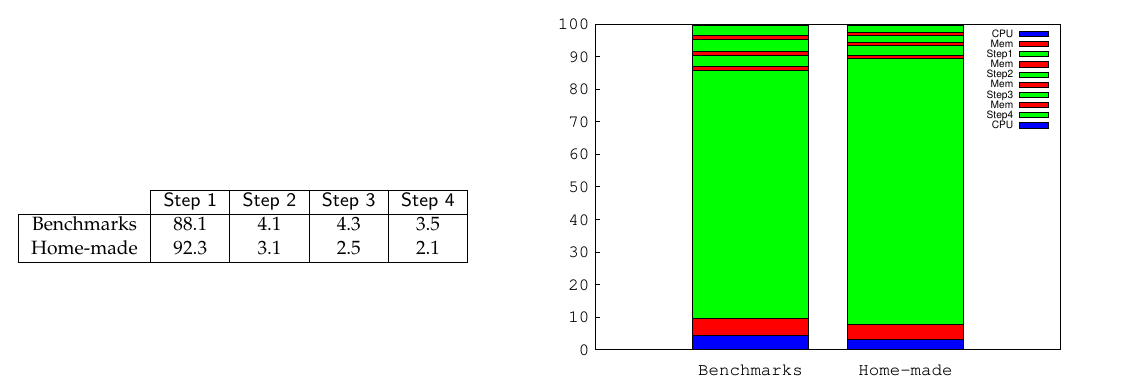
Figure 7. A deeper analysis of our application in terms of time costs. The table presents the relative costs of the different algorithmic phases (from step 1 to step 4) illustrated by Algorithm 2. The histogram reports the relative effort of the, somehow interleaved, CPU and GPU activity.